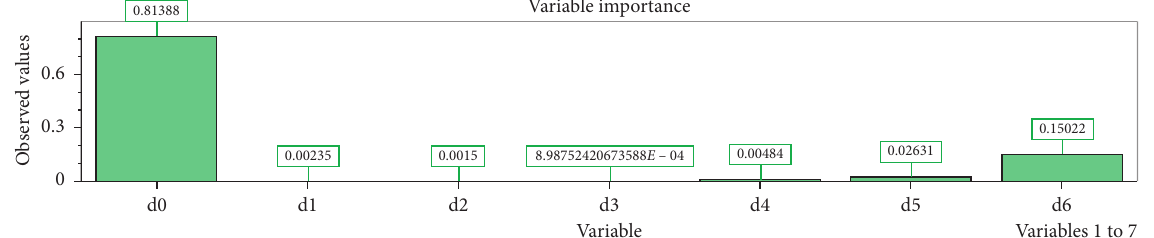
Figure 6: R value variable importance of observed values and the input variable; (d0) HARHA; (d1) w A C ; (d6) δ max